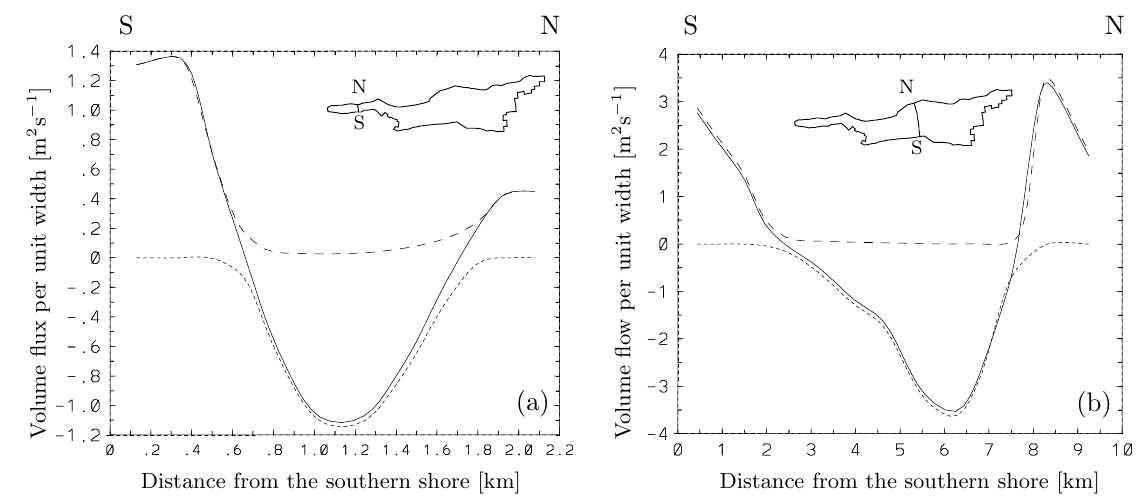
FIG. 17: Vertically integrated volume flux per unit width in the cross-sections of the center of the ¨Uberlinger See (a) and in the Obersee (b) computed with the vertical eddy viscosity ν v = 0 . 02m 2 s − 1 . Broken curves indicate the transport part with the wind direction, dotted curves against the wind direction. The solid lines show the sum of the two. The location of the cross-sections is shown as inset.